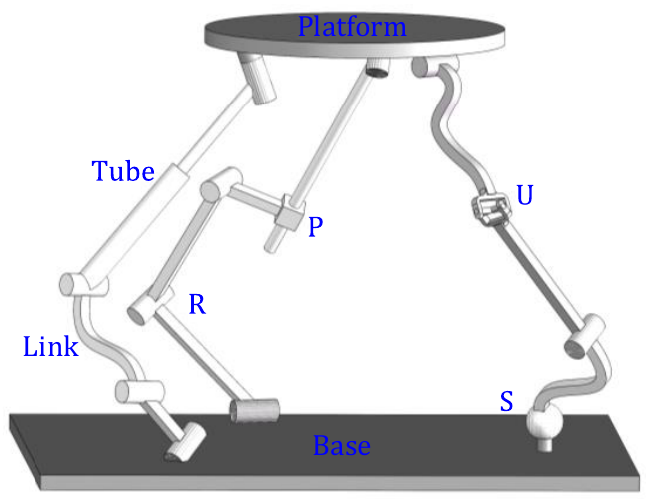
Figure 1. Parallel mechanism in matrix structural analysis. With the energy method, by summing each element’s kinematic energy, elastic po- tential energy, and external force virtual work, the vibration equation of the PM can be obtained through the Lagrange formulation. The core of the MSA is to obtain the stiffness and mass matrices of the flexible elements, which are connected by complex kinematic joints. According to the connection type, the elements are classified into two main cases by Cammarata [11]: the rigid body–flexible beam and the flexible beam–flexible beam. Flexible elements in these two cases are two-node beam elements. They are connected at the top node and the end node. We added the outer tube–inner tube case to simulate the tube structure in a